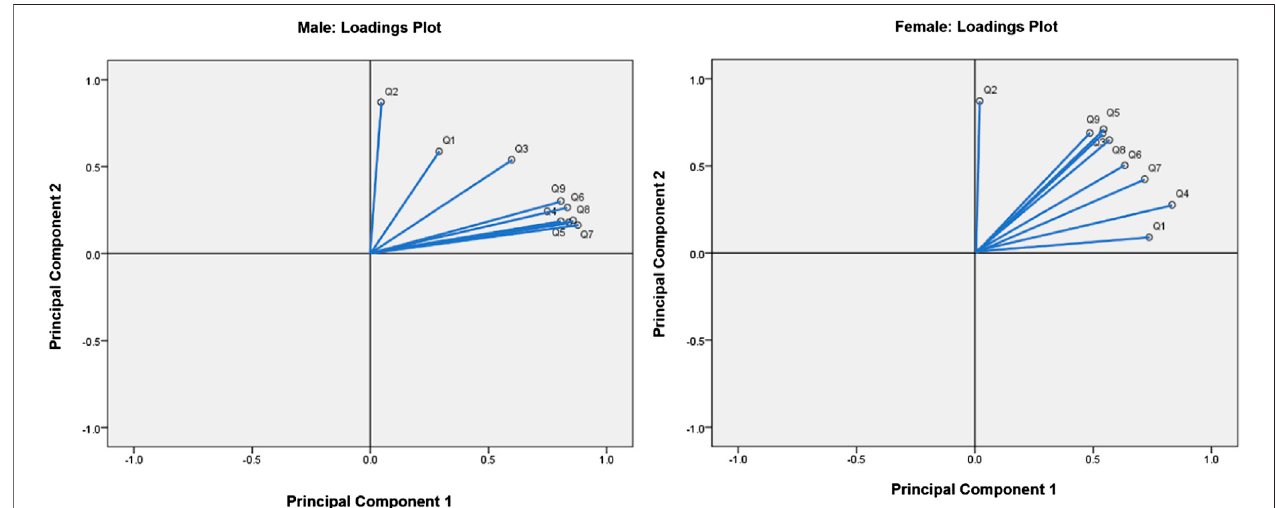
FIGURE 6 | Loadings plots for males and